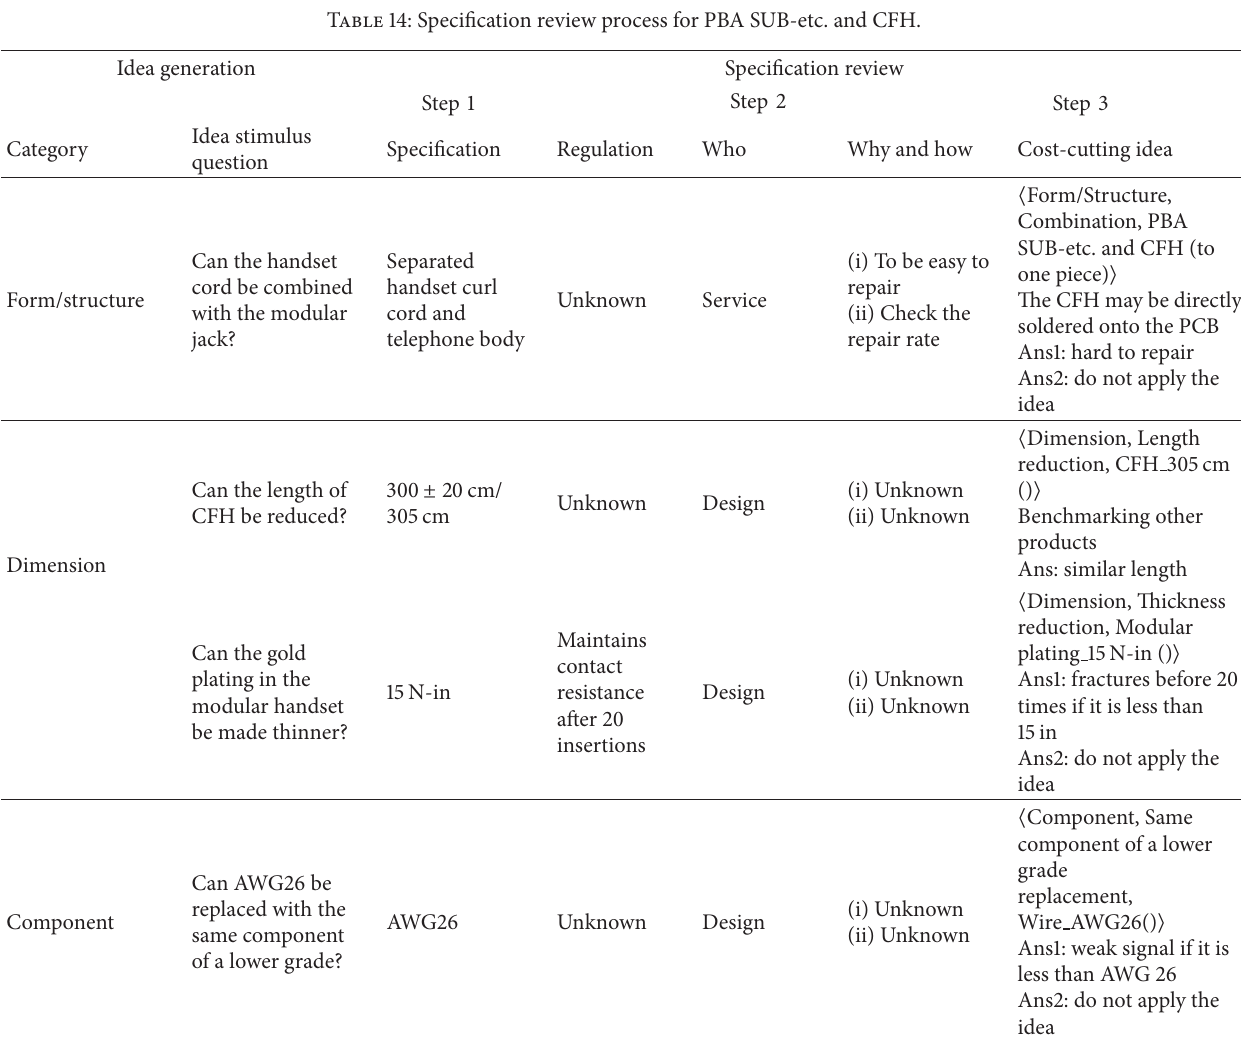
Table 14: Specification review process for PBA SUB-etc. and